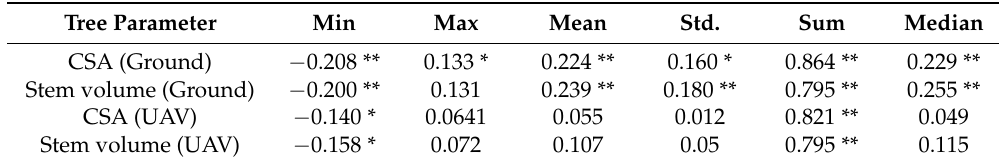
Table 4. Pearson correlation between the UAV spectral descriptive data and tree attributes at the level of individual ID 1 indicates the relation between the ground CSA versus ground crown projection; ID 2 indicates the relation between the crown projection derived from UAV and ground data; ID 3 indicates the relation between the CSA derived from the UAV and ground data; ID 4 indicates the relation between the estimated height from the UAV and ground data; and ID 5 indicates the relation between the stem volume derived from the UAV and ground data.